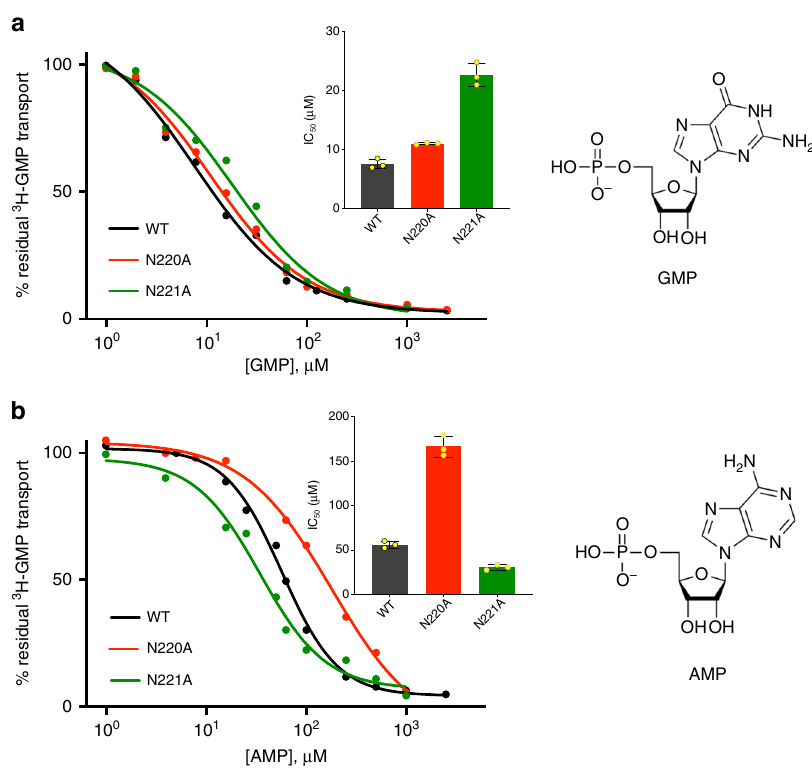
Fig. 3 The FYNN motif mediates nucleotide discrimination. a Representative IC 50 curves determined for GMP in wild type (WT), N220A and N221A variants. b Representative IC 50 curves determined for AMP in wild type (WT), N220A and N221A variants. The chemical structures of GMP and AMP are shown for reference. Insets show the calculated IC 50 value from three independent experiments, errors shown are s.d. of the mean. Source data are provided as a Source Data fi